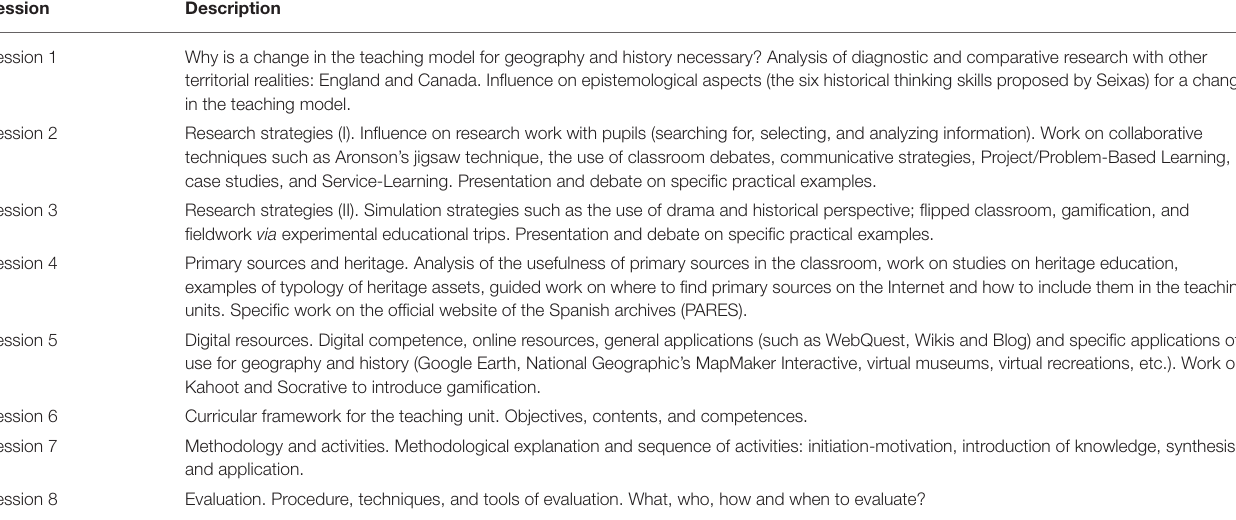
TABLE 1 | Definition of the sessions of the formative